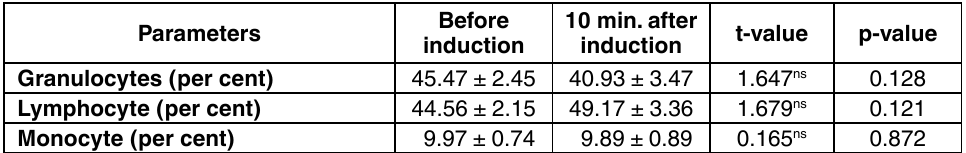
Table 2. Comparison of differential leukocyte count before anaesthetic induction and 10 minutes